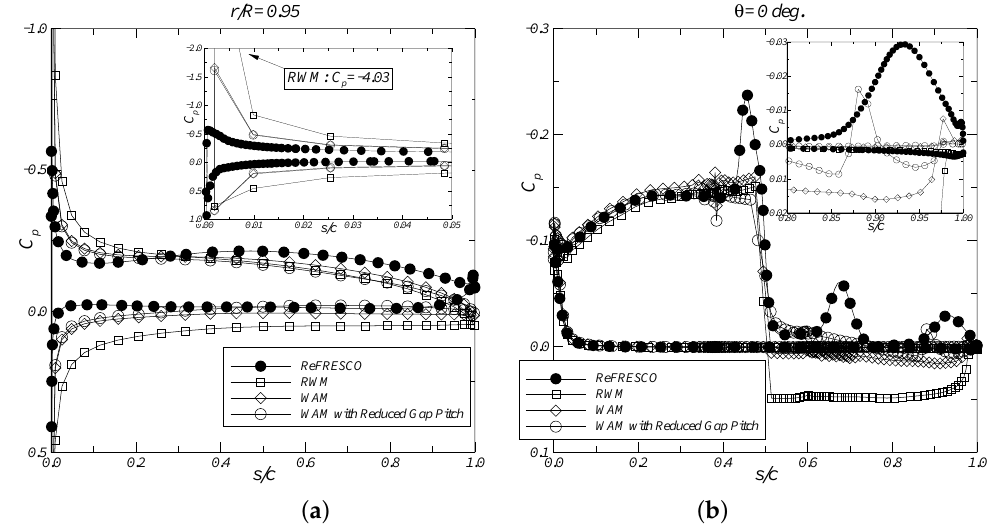
Figure 9. Blade chordwise pressure distribution at r / R = 0.95 ( a ); Duct chordwise pressure distribution at θ = 0 degrees ( b ). J =